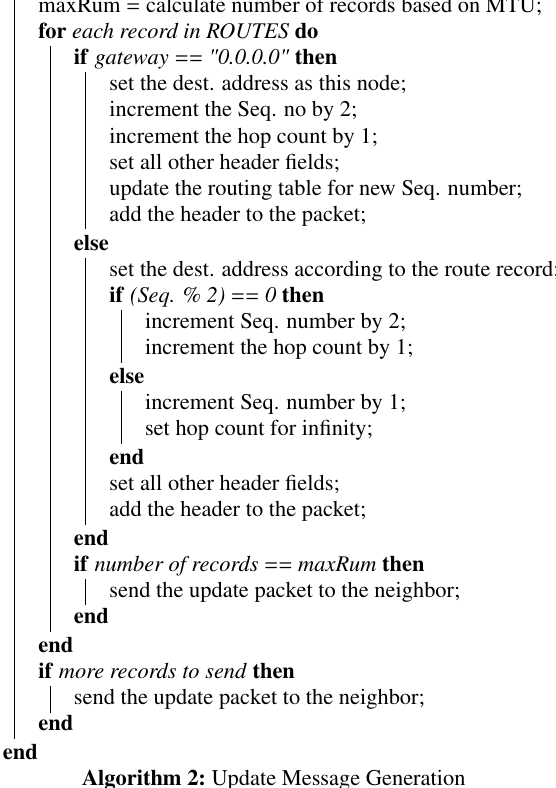
Algorithm 2: Update Message